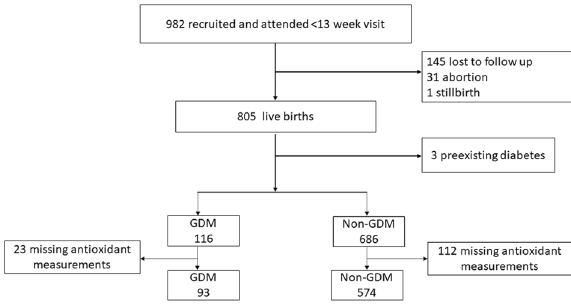
Fig. 1 Flow diagram of study population. GDM gestational diabetes